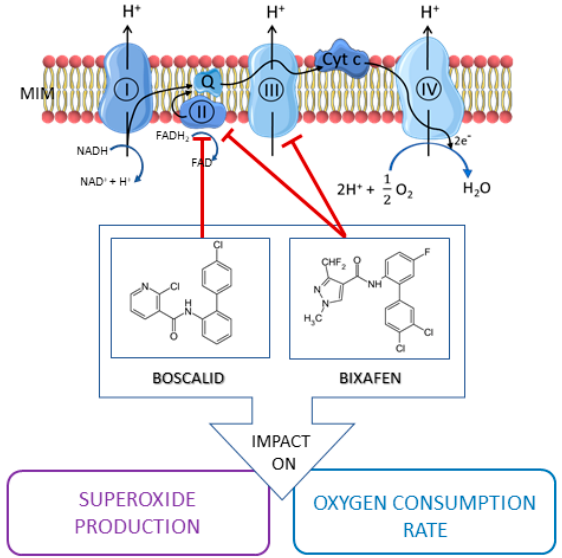
Figure 1. Effect of SDHI-fungicides on mitochondrial ETC. Boscalid and Bixafen block the complex II of the ETC, Bixafen also inhibiting complex III. By disrupting mitochondrial function, SDHIs may impact the production of mitochondrial superoxide radical and the oxygen consumption rate.